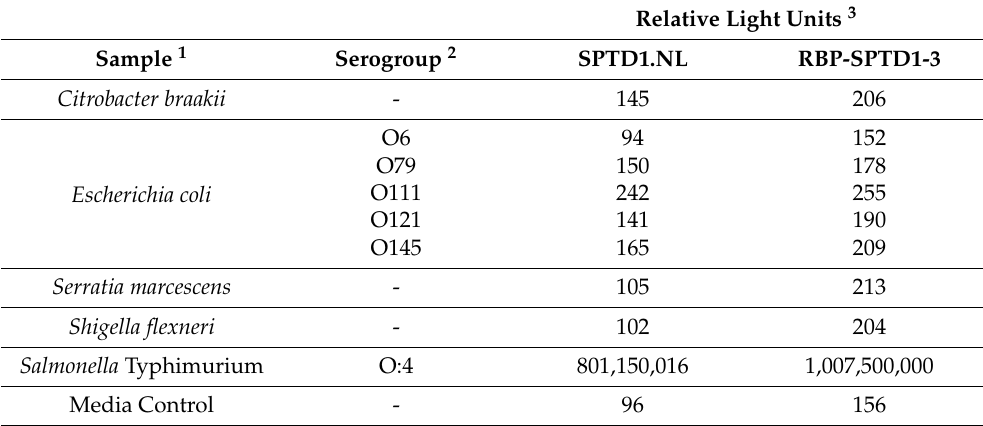
Table 4. Comparison of SPTD1.NL and RBP-SPTD1-3 Reporter Specificity with High Bacterial